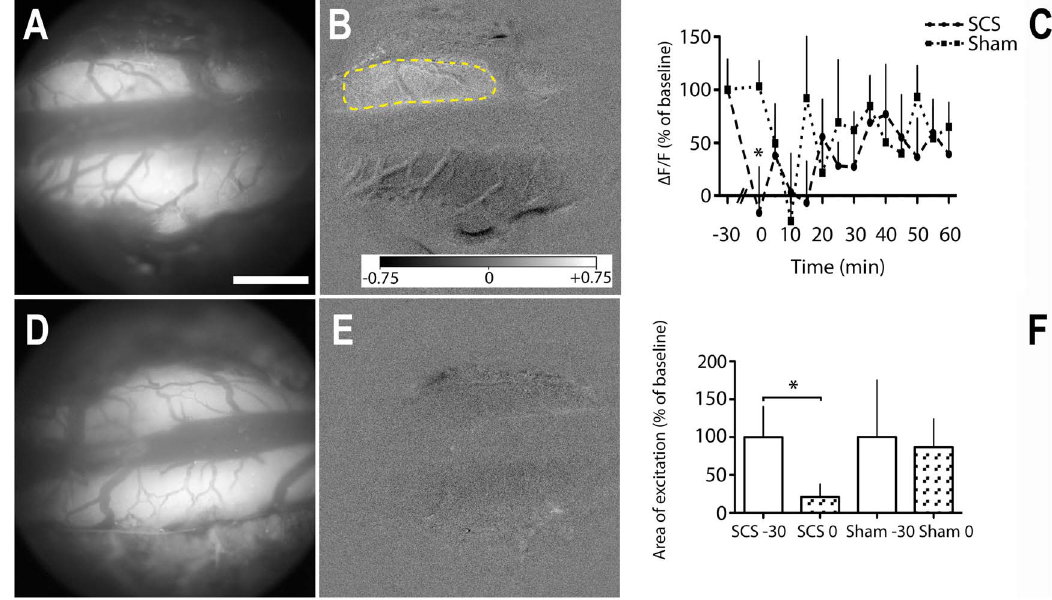
Figure 5. Effect of 30 minutes SCS or sham stimulation on the intensity of the AFI signal and area of excitation in response to sciatic nerve electrical stimulation, in rats with partial ligation of the proximal sciatic nerve (Seltzer model). (A,D) Images of background fluorescence of the dorsal surface of the spinal cord at T13 of a sham (A) and SCS treated rat (D). (B,E) Area of excitation (yellow) on the ipsilateral side, directly after sham stimulation (B); after SCS, in this rat, there is no area exceeding the predefined D F/F level (E). (C) Time course of the intensity of the AFI signal after SCS or sham stimulation (T=0 min), as a percentage of D F/F before treatment (T=-30 min), in 20 6 20 pixel square selections on the ipsilateral side at the L4-L6 spinal level. (F) Mean areas of excitation on the ipsilateral side directly after SCS or sham stimulation (T=0 min), as a percentage of the areas before treatment (T=-30 min). Scale bar, 1 mm; Grayscale bar ranging from 2 0.75% (black) to + 0.75% (white) of the 16-bit range; Error bars indicate SEM; * p , 0.05; paired t -tests; n =7 SCS, n =6 sham